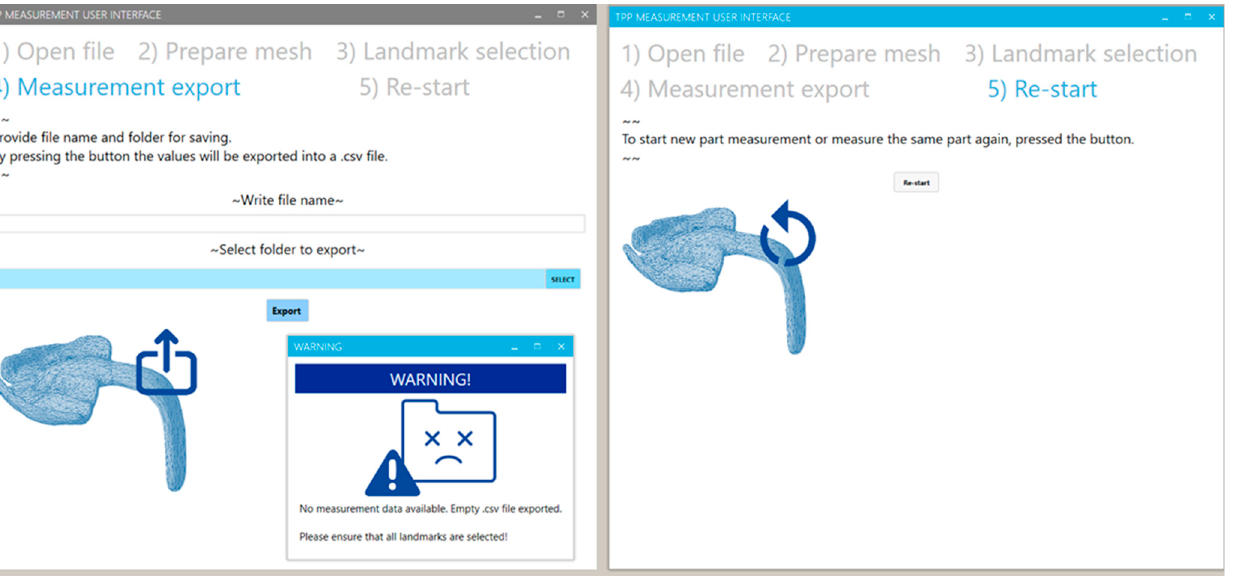
Figure 16. User interface view for the tabs of “measuring export” ( left ) and “re-start” ( right ). For an uncompleted measurement protocol or export document, a warning window appears ( right ).